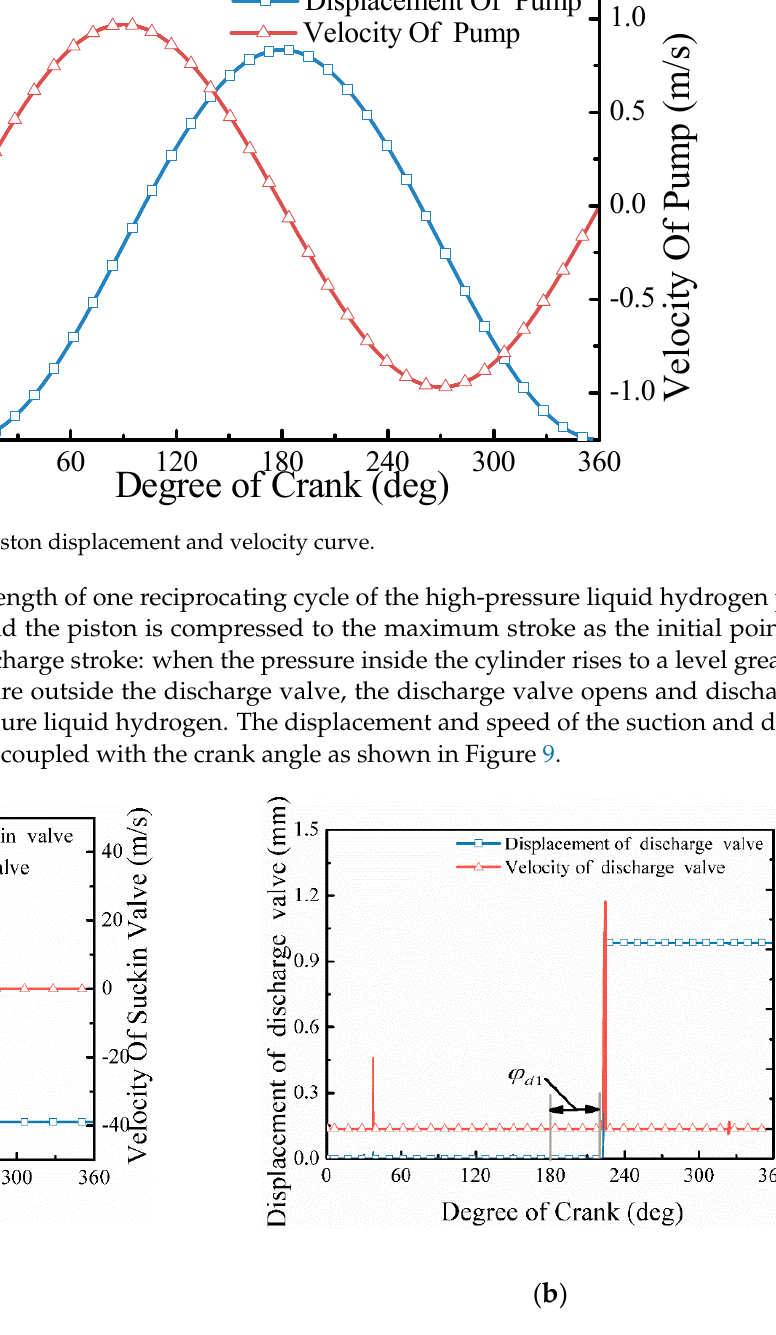
Figure 7. Internal liquid hydrogen pressure diagram of reciprocating pump at different crank angles. ( a ) Crank angle 40°. ( b ) Crank angle 110°. ( c ) Crank angle 220°. ( d ) Crank angle 280°.